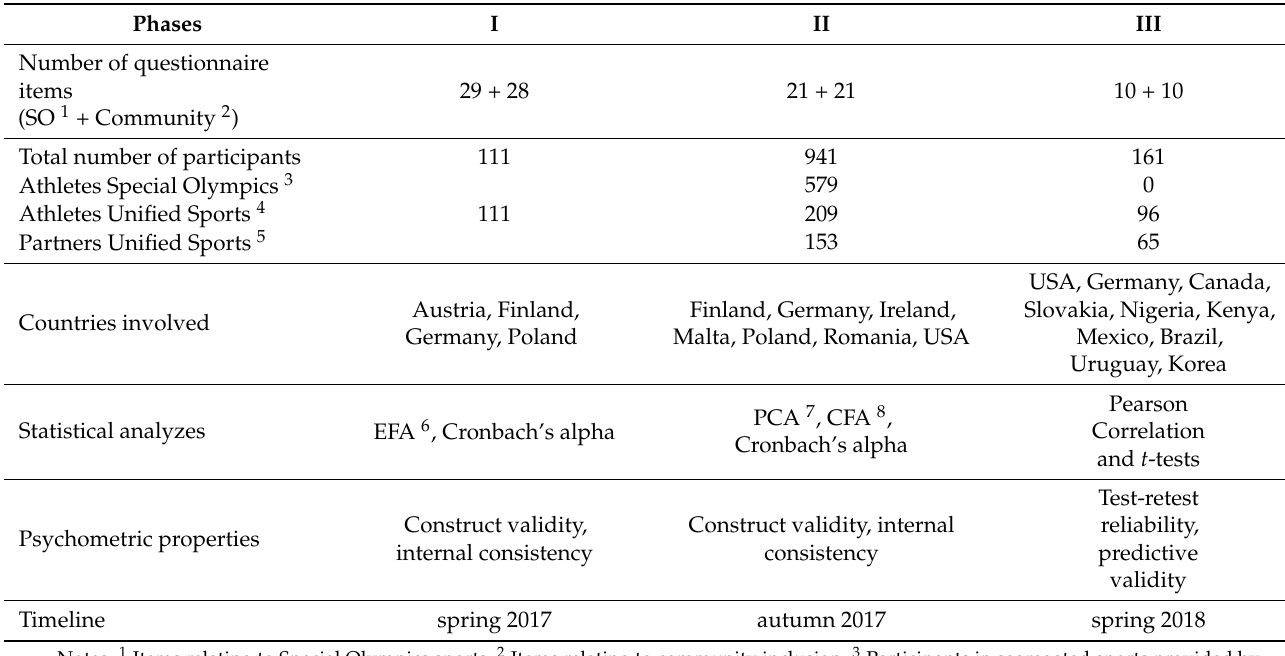
Figure 1. An example of questionnaire items. Table 1. Descriptive information of the three phases of questionnaire